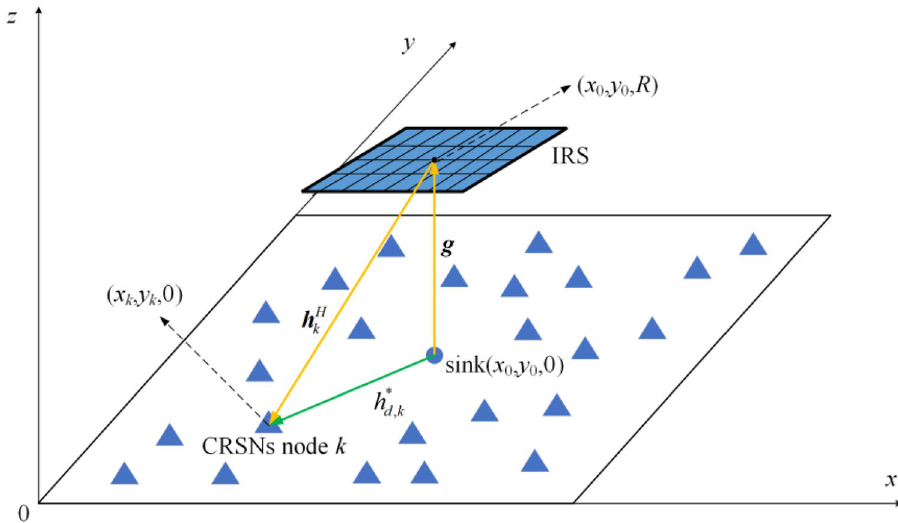
Figure 2. Network architecture of IRS-aided